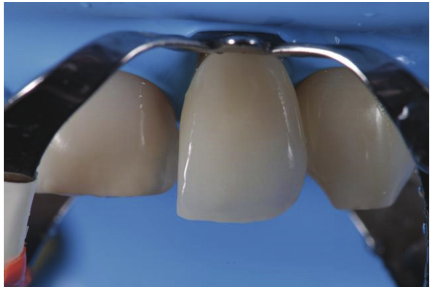
Figure 5: Intraoral evaluation of milling CAD-CAM mockup.